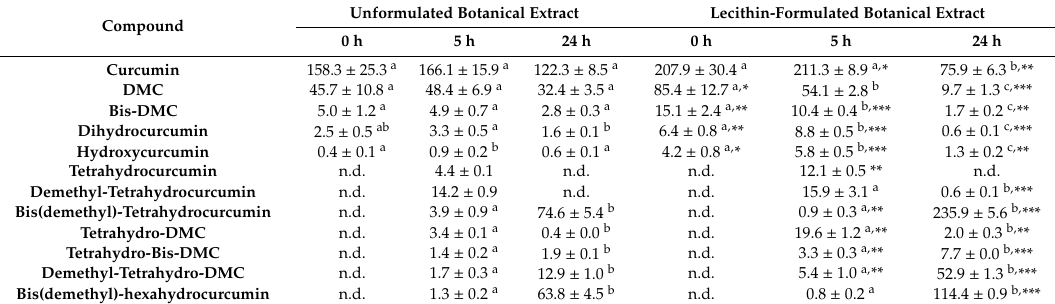
Figure 1. Proposed microbial conversion of native curcuminoids in their fecal metabolites. Table 3. Concentration ( µ mol / L) of native curcuminoids and their faecal metabolites at di ff erent time